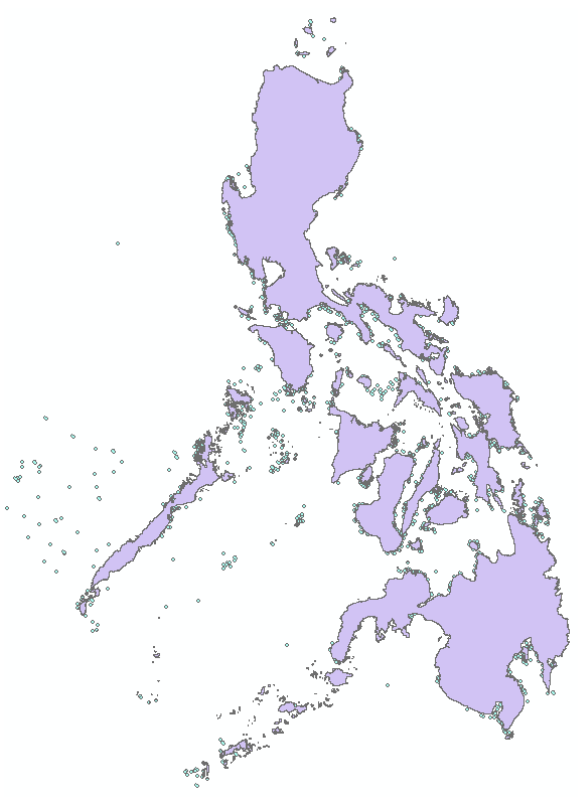
Figure 6. Coral reefs.